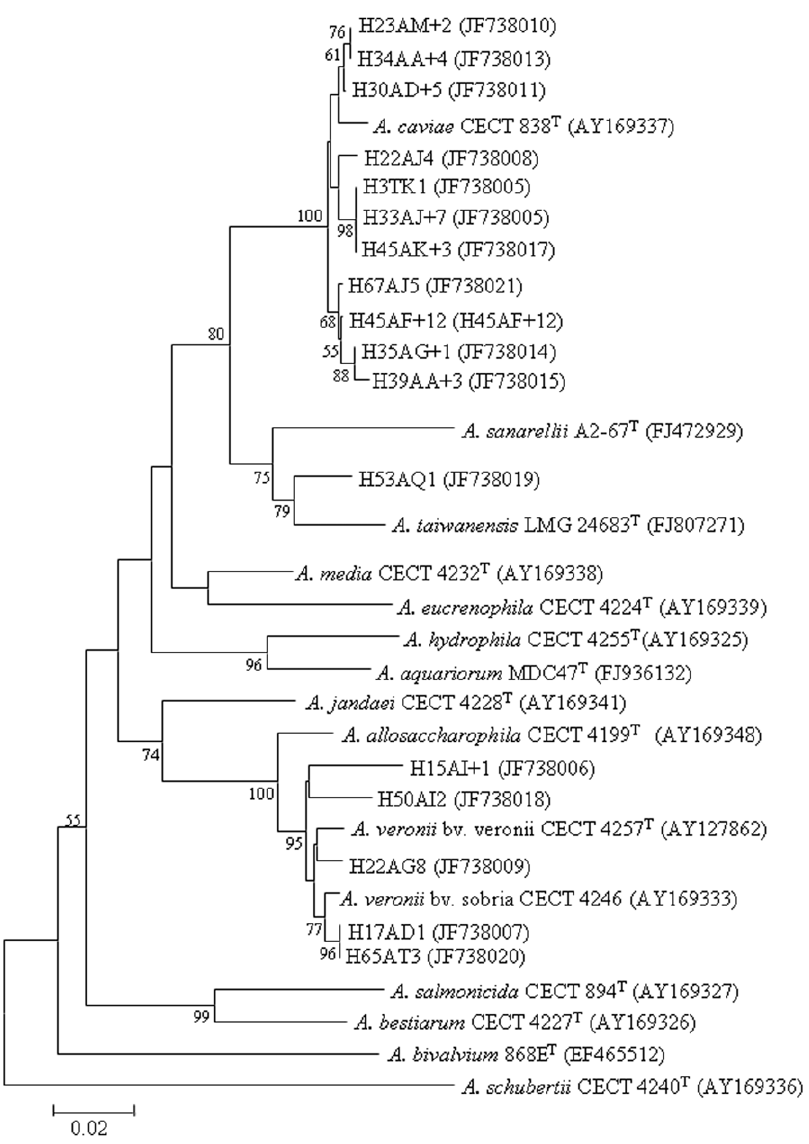
Figure 1. Phylogenetic tree of Aeromonas isolates recovered from diarrhea patients. The tree shows the relationships based on partial sequences of rpoD gene of type strains of Aeromonas species and the isolates from the current study. The sequence alignments were performed using the CLUSTAL W program, and the tree was generated using the neighbor–joining method with Kimura 2 parameter distances in MEGA 4.1 software. Bootstrap values (from 1,000 replicates) greater than 50% are shown at the branch points. The bar indicates 2% sequence